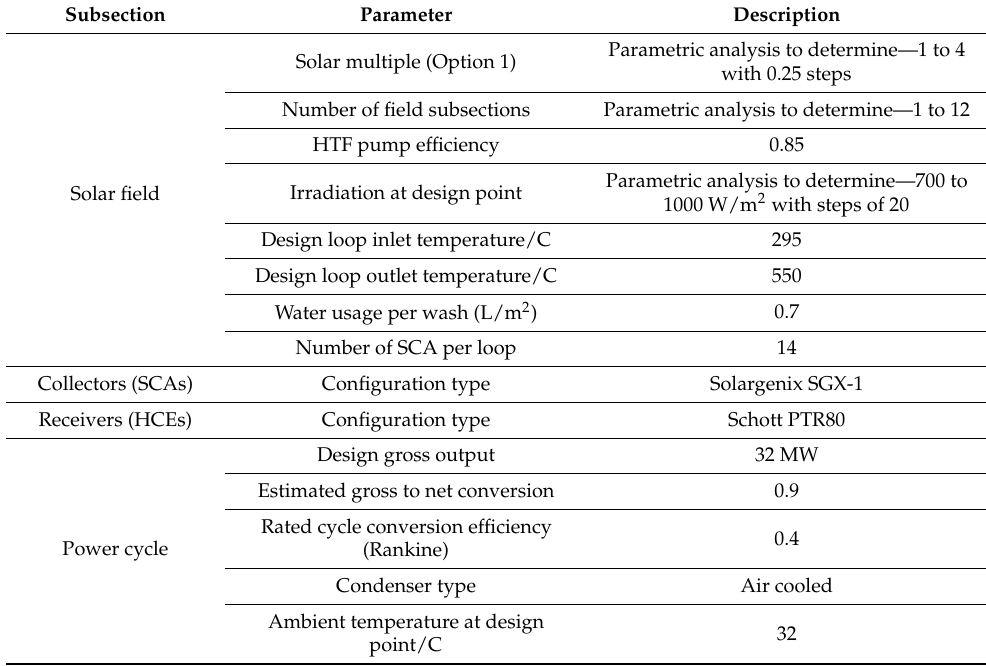
Table 10. Technical parameters for CSP. Data from